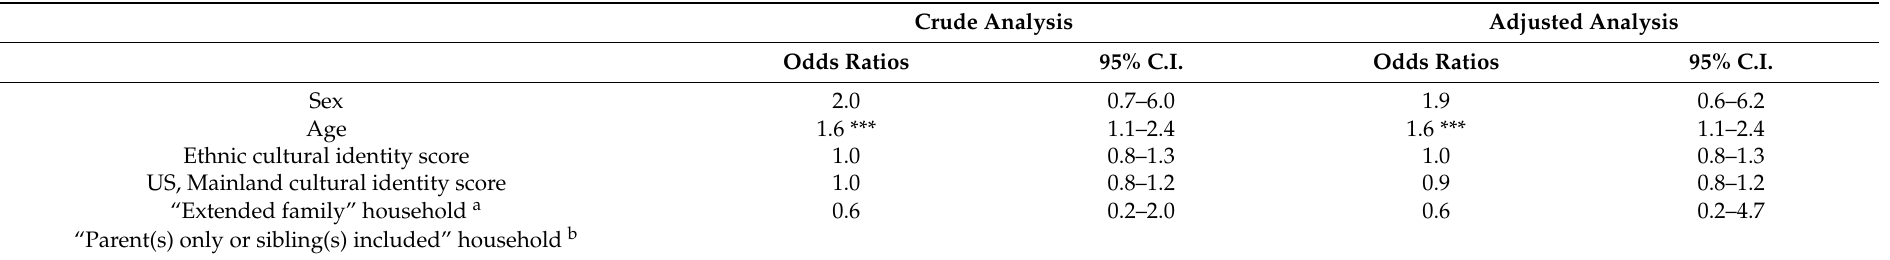
Table 5. Multivariable logistic regression results examining the association between meeting the MDD indicator and selected explanatory variables a in infants 6–12 Months ( n =